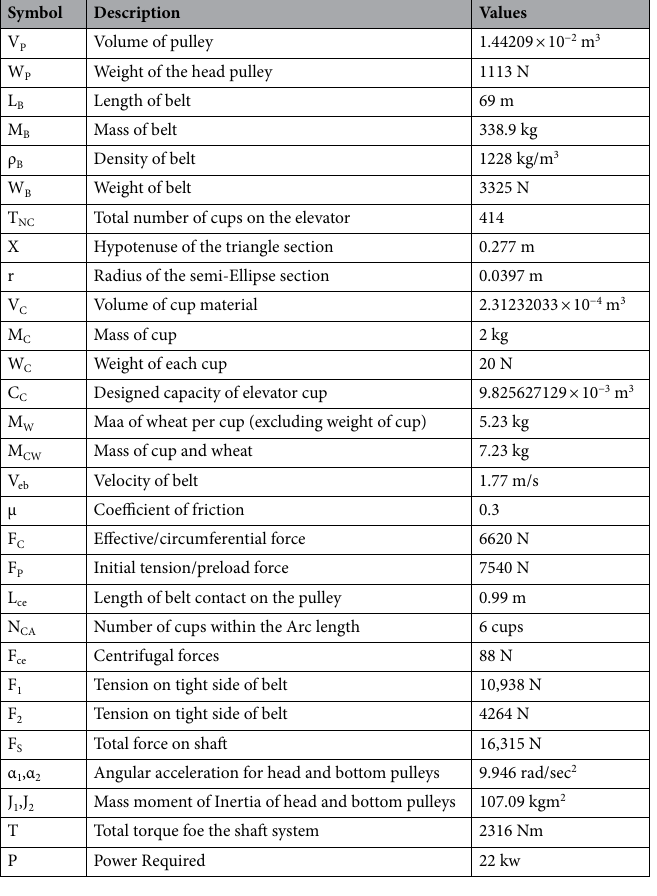
Table 2. Calculated parameter values based on Table 1 definition.